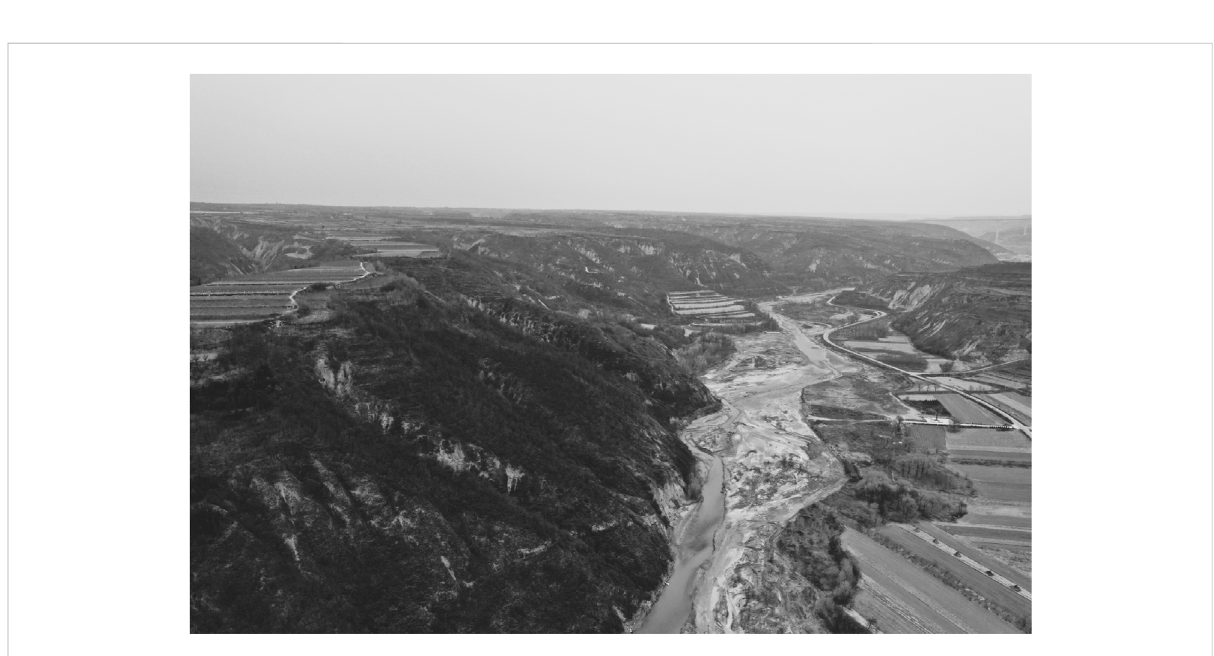
FIGURE 2 The landscape of the Jing River Valley. Photo credit: Xiao